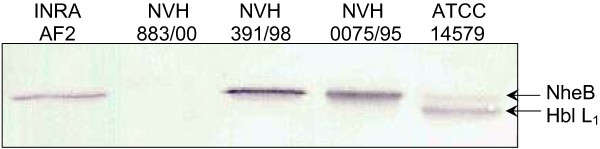
Detection of NheB in culture supernatants. Western immunoblot of culture supernatants from B. cereus strains INRA AF2, NVH 883/00, NVH 391/98, NVH 0075/95 and ATCC 14579 detected using the 1C2 antibody, reactive against both NheB and Hbl component L1. Samples were collected from late log phase cultures grown at 32°C. NVH 0075/95 and ATCC 14579 were used as controls; NVH 0075/95 does not contain hbl, while ATCC 14579 produces both Nhe and Hbl. The results show that strains NVH 391/98 and INRA AF2 produce NheB.